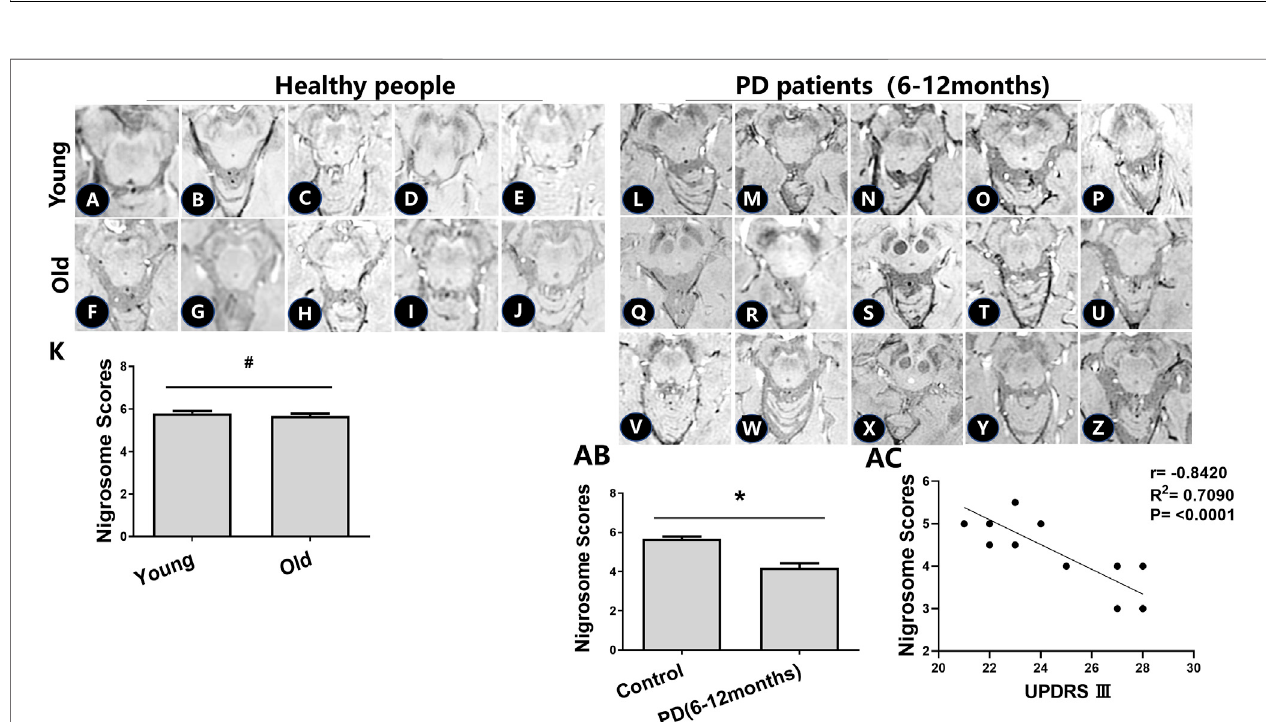
FIGURE2| IronaccumulationinthenigrosomeofhealthypeopleandPDpatientswitha6 – 12-monthdiseaseduration. (A – J) AlterationsinthenigrosomeonSWIin young and healthy older people. (K) Mean nigrosome scores were statistically analyzed in young and healthy older people; # compared with young healthy people, p > 0.05. (L-Z) Alterations in the nigrosome on SWI in PD patients. (AB) Mean nigrosome scores in PD patients were statistically compared with those in healthy older people. Mean nigrosome scores were calculated by utilizing the bilateral nigrosome scores in three axial sections of the brain; * compared with the control group, p < 0.05. (AC) Correlation analysis was used to evaluate the relationship between UPDRS III and nigrosome scores.